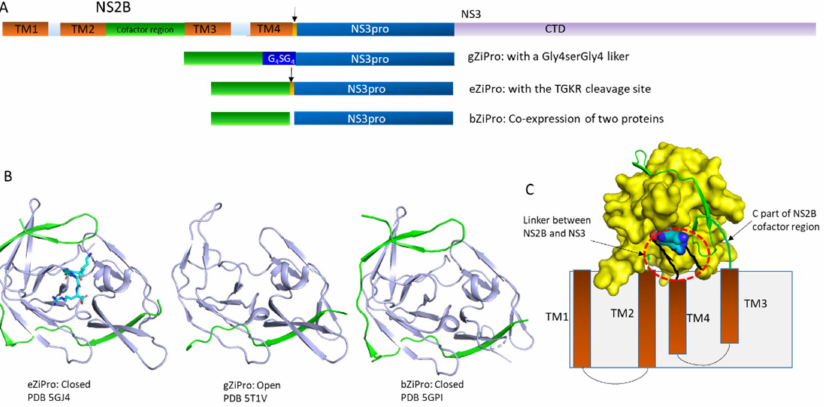
Figure 2. Open and closed conformations in ZIKV proteases. ( A ). Artificial constructs for structural studies of ZIKV protease. The domains of NS2B and NS3 are shown in different color. Transmembrane helices of NS2B are indicated as TM1-4. The cofactor region of NS2B interacting with NS3 and regulating protease activity is shown in green. The arrows indicate the native protease cleavage site between NS2B and NS3. The protease domain of NS3 is indicated as NS3pro and C-terminal region of NS3 is indicated as CTD. Artificial constructs without a linker, with a glycine-rich linker and the native protease cleavage site are indicated as bZiPro, gZiPro, and eZiPro, respectively. ( B ). Structures of the free ZIKV protease. Protease is in the closed conformation in the presence of an inhibitor. The NS2B cofactor region and NS3pro are shown in green and light blue, respectively. The PDB access codes are shown in the figure. All the structures are shown in the same orientation. The TGKR sequence is shown in sticks. ( C ). A model of ZIKV protease on the cell membrane. The transmembrane domains of NS2B are indicated as TMs. The boundary between NS2B and NS3 is highlighted with a red cycle. NS2B cofactor and NS3pro are shown in green and yellow, respectively. The dynamic nature of substrate is critical for its dissociation with protease, which is critical for releasing other